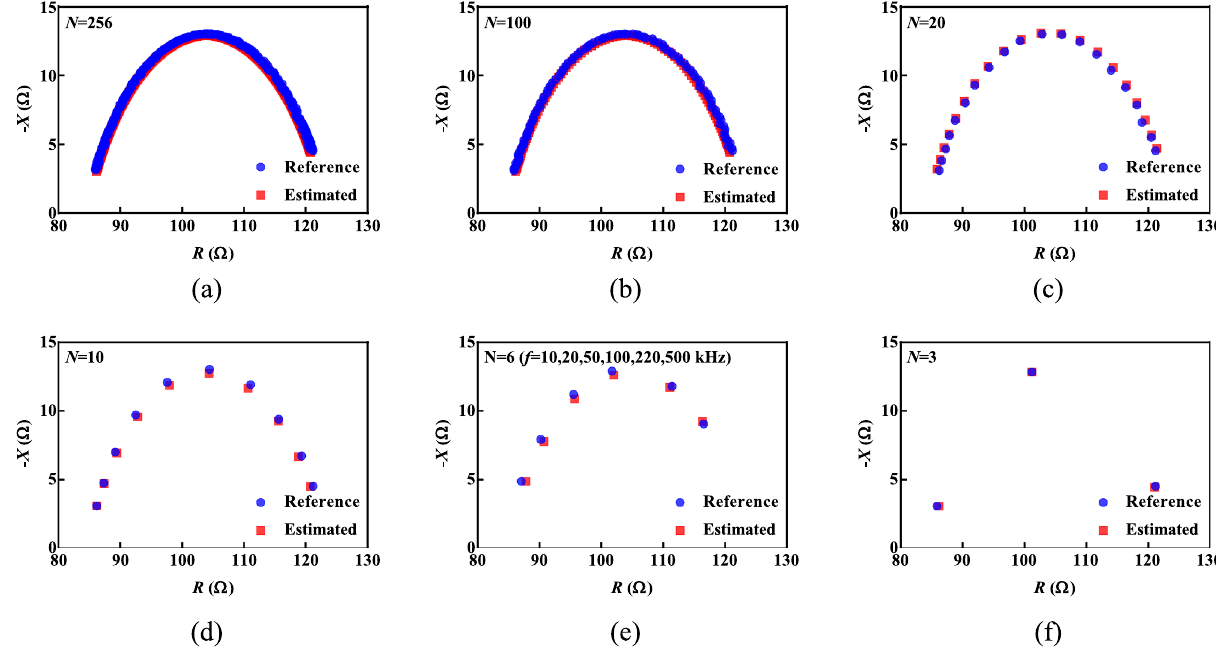
Figure 5. The Nyquist plots of reference and estimated values for different number of measurement points: ( a ) 256, ( b ) 100, ( c ) 20, ( d ) 10, ( e ) 6 and ( f )